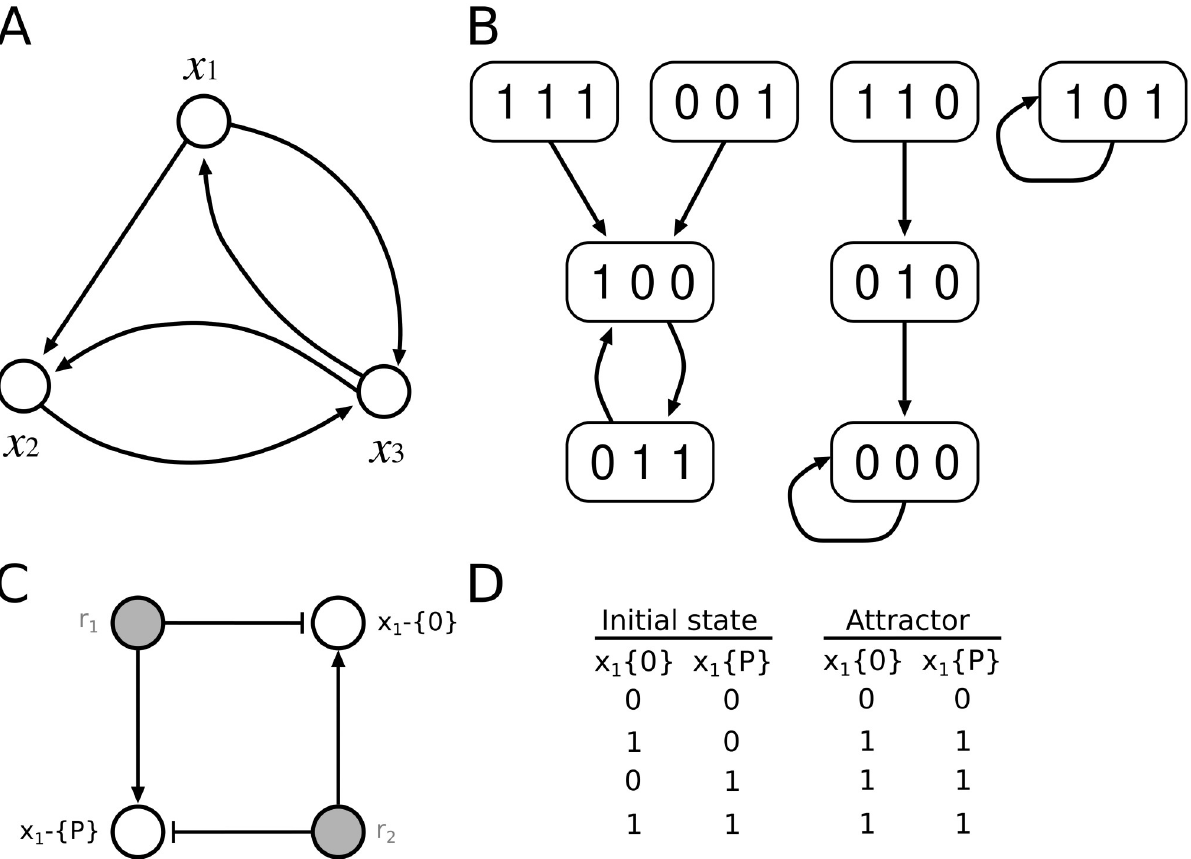
Fig 1. Example of a BN. (A) Network structure G ( V , E ) for a BN consisting of n = 3 nodes x 1 , x 2 , and x 3 . The Boolean functions are represented by the edges. (B) State transition diagram of all 2 3 = 8 states of the BN represented in (A). (C) Simplification of a bBM for a phosphorylation- dephosphorylation system as elemental species-reaction graph. The nodes corresponding to elemental states of component x 1 are shown in black, the nodes corresponding to reactions are shown with grey fillings. Here, a component (protein) x 1 undergoes phosphorylation by consuming its elemental state x 1 -{0} to produce its modified state x 1 -{P} by reaction r 1 (phosphorylation). The modified x 1 -{P} undergoes consumption thereby producing the neutral state x 1 -{0} via reaction r 2 (dephosphorylation) (details in [29]). (D) Relationship between initial states of both elemental states x 1 -{0} and x 1 -{P} of component x 1 and the attractors. When at least either of the two elemental states x 1 -{0} or x 1 -{P} are active in the initial state, both will be active in the attractor. Both elemental states need to be inactive in the initial state to be absent (inactive) in the attractor state. Both reaction nodes r 1 and r 2 are assumed to be active in this example and are not shown. Synthesis and degradation are not considered here. In the example, standard update rules are applied, where two mutually exclusive states can be simultaneously present. More details can be found in